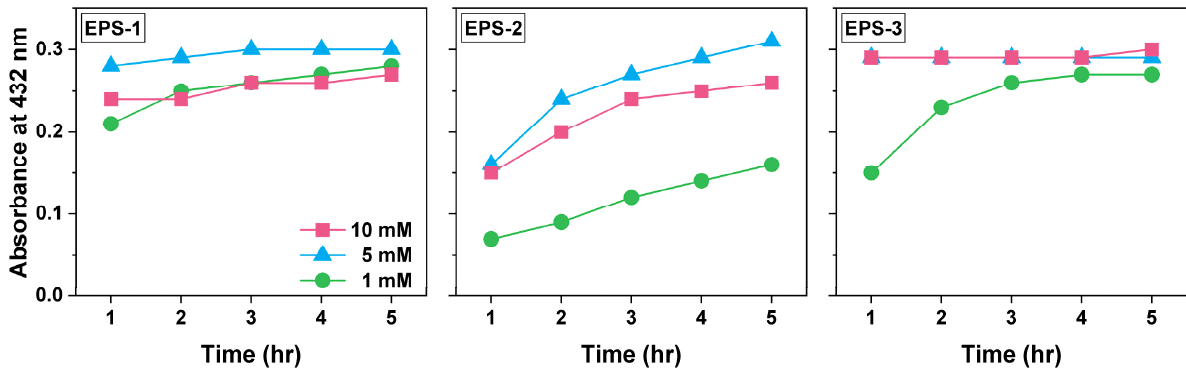
Figure 2. UV–Vis light absorbance at 432 nm of AgNO 3 and EPS solution mixture at 25, 70, and 100 ◦ C, respectively. Each reaction mixture contained 10 mM AgNO 3 and 0.5 g L − 1 EPS.